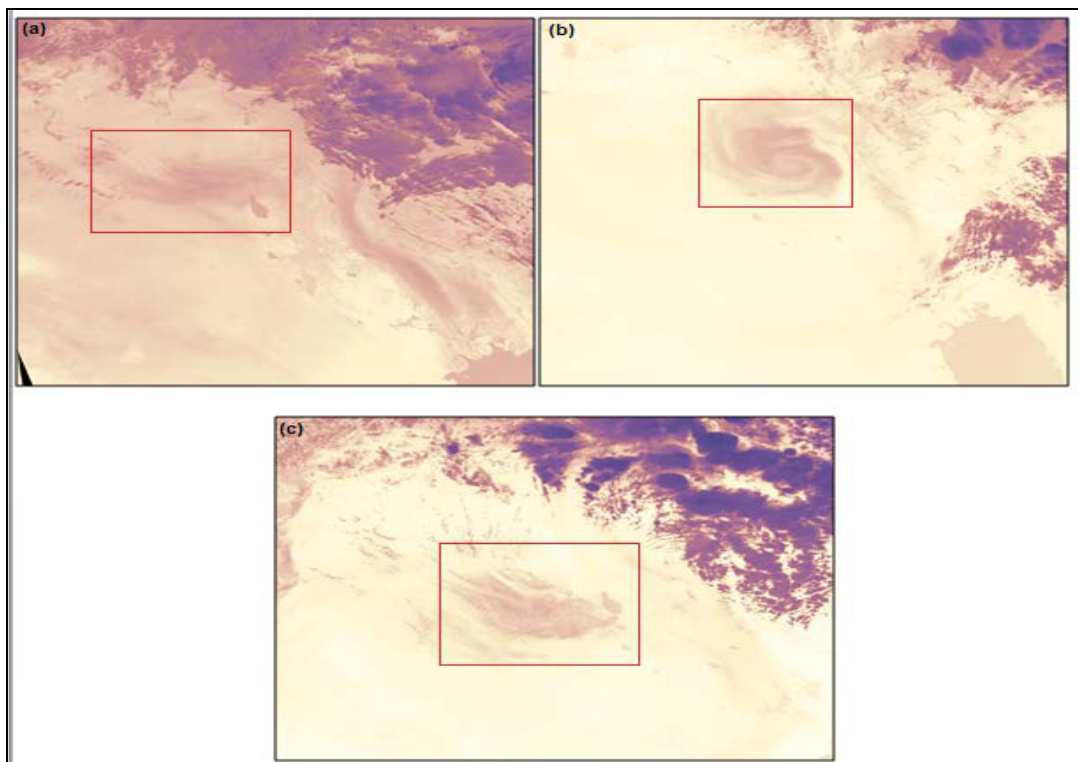
Fig.7: (a) Applying BTD on 16/6/2016 MODIS image, (b) using BTD on 1/9/2015 M0DIS image, (c) by BTD on 20/2/2016 MODIS